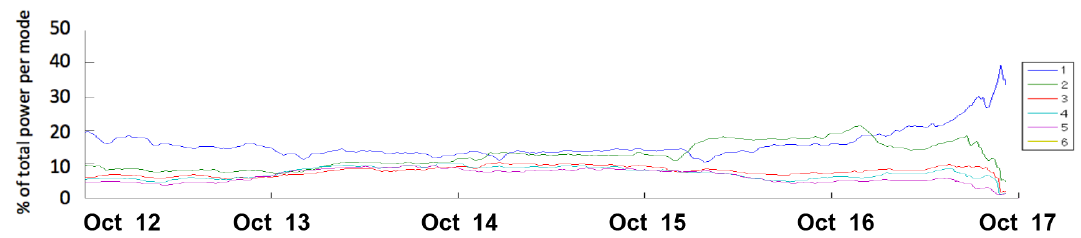
Figure 4. Calculations of the power per wave number using cross-spectrogram calculations between GOES-14 and GOES-15, at an azimuthal separation of ∼ 30 ◦ ; the fractions of power in one of the wave numbers m = 1 to 5 over total power in a time bin is